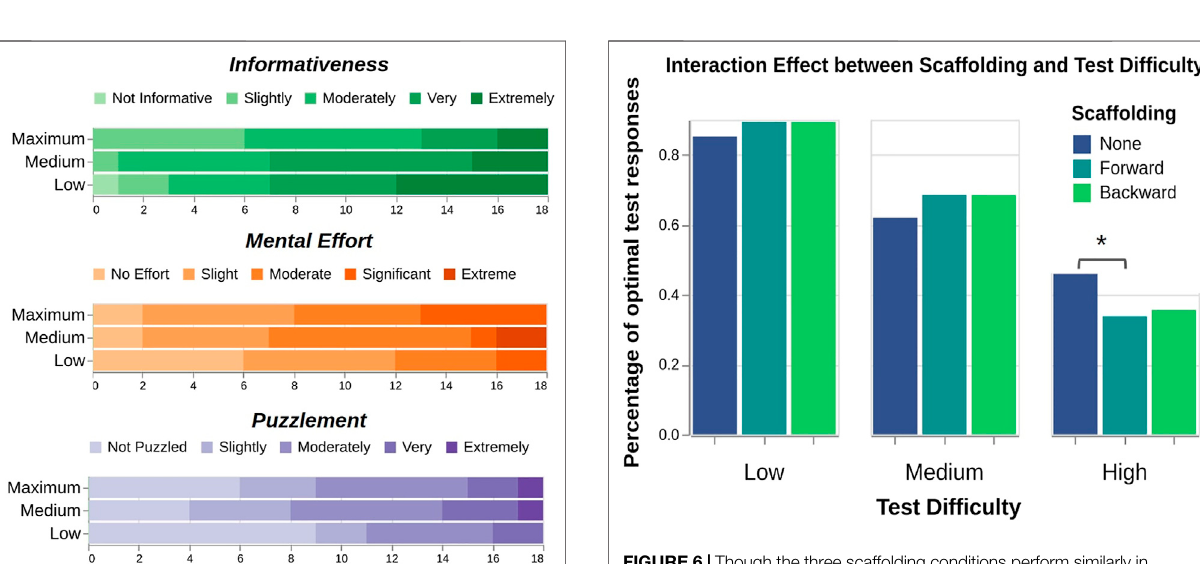
FIGURE 6 | Though the three scaffolding conditions perform similarly in aggregate across all tests, “ no scaffolding ” signi fi cantly increases performance for high dif fi culty